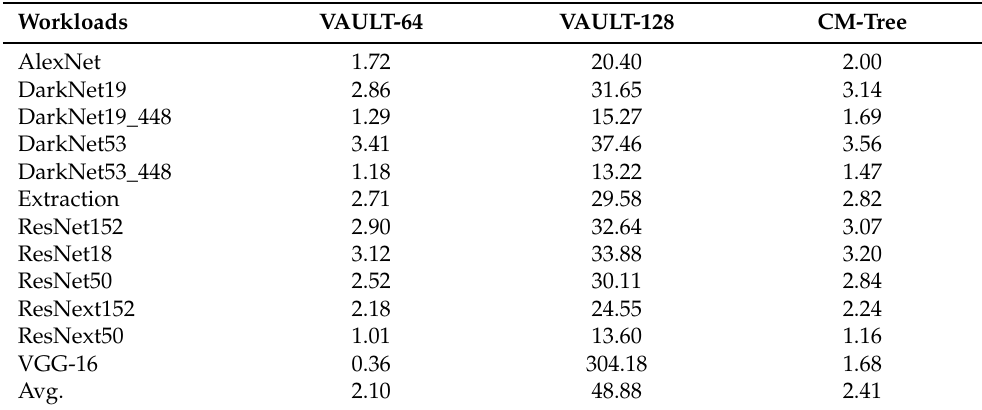
Table 7. Overflows per million instructions for VAULT-64, VAULT-128, and Countermark-tree. Workloads